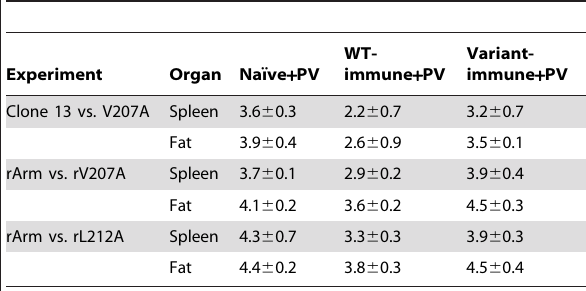
Table 1. Abrogation of heterologous immunity by point mutation in NP205.